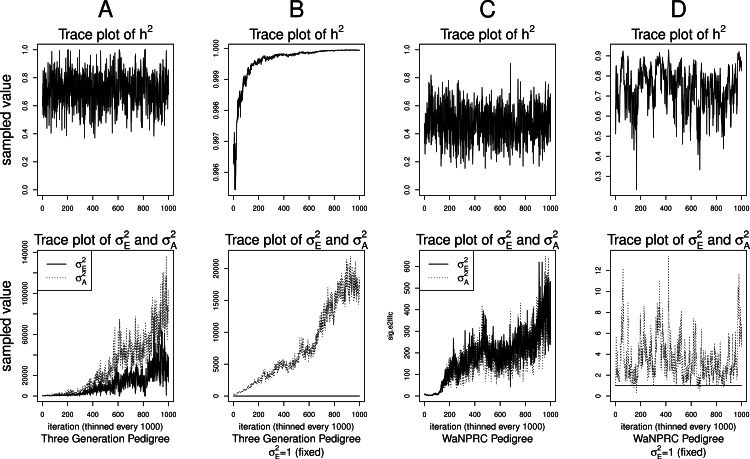
Variance components and heritability traceplots.Four scenarios are shown here, with traceplots of \documentclass[12pt]{minimal}
\usepackage{amsmath}
\usepackage{wasysym} 
\usepackage{amsfonts} 
\usepackage{amssymb} 
\usepackage{amsbsy}
\usepackage{upgreek}
\usepackage{mathrsfs}
\setlength{\oddsidemargin}{-69pt}
\begin{document}
}{}${h}^{2}={\sigma }_{A}^{2}/({\sigma }_{A}^{2}+{\sigma }_{E}^{2})$\end{document}h2=σA2/σA2+σE2 on top, and traceplots of the individual variance components on the bottom. The first scenario (column A) is the three generation pedigree. While the MCMC samples of each individual variance component clearly do not show convergence (bottom), we observe that when we examine the corresponding values of h2, this does appear to be stable (top). Conversely, when we fix \documentclass[12pt]{minimal}
\usepackage{amsmath}
\usepackage{wasysym} 
\usepackage{amsfonts} 
\usepackage{amssymb} 
\usepackage{amsbsy}
\usepackage{upgreek}
\usepackage{mathrsfs}
\setlength{\oddsidemargin}{-69pt}
\begin{document}
}{}${\sigma }_{E}^{2}=1$\end{document}σE2=1, this does not appear to stabilize the MCMC samples of \documentclass[12pt]{minimal}
\usepackage{amsmath}
\usepackage{wasysym} 
\usepackage{amsfonts} 
\usepackage{amssymb} 
\usepackage{amsbsy}
\usepackage{upgreek}
\usepackage{mathrsfs}
\setlength{\oddsidemargin}{-69pt}
\begin{document}
}{}${\sigma }_{A}^{2}$\end{document}σA2 here, and h2 → 1 as shown in the top and bottom panels of column B. With the WaNPRC pedigree (C and D), we again observe that without fixing \documentclass[12pt]{minimal}
\usepackage{amsmath}
\usepackage{wasysym} 
\usepackage{amsfonts} 
\usepackage{amssymb} 
\usepackage{amsbsy}
\usepackage{upgreek}
\usepackage{mathrsfs}
\setlength{\oddsidemargin}{-69pt}
\begin{document}
}{}${\sigma }_{E}^{2}=1$\end{document}σE2=1, the MCMC samples of h2 does indicate convergence despite the fact that those for \documentclass[12pt]{minimal}
\usepackage{amsmath}
\usepackage{wasysym} 
\usepackage{amsfonts} 
\usepackage{amssymb} 
\usepackage{amsbsy}
\usepackage{upgreek}
\usepackage{mathrsfs}
\setlength{\oddsidemargin}{-69pt}
\begin{document}
}{}${\sigma }_{A}^{2}$\end{document}σA2 and \documentclass[12pt]{minimal}
\usepackage{amsmath}
\usepackage{wasysym} 
\usepackage{amsfonts} 
\usepackage{amssymb} 
\usepackage{amsbsy}
\usepackage{upgreek}
\usepackage{mathrsfs}
\setlength{\oddsidemargin}{-69pt}
\begin{document}
}{}${\sigma }_{E}^{2}$\end{document}σE2 individually do not. On the other hand, when fixing \documentclass[12pt]{minimal}
\usepackage{amsmath}
\usepackage{wasysym} 
\usepackage{amsfonts} 
\usepackage{amssymb} 
\usepackage{amsbsy}
\usepackage{upgreek}
\usepackage{mathrsfs}
\setlength{\oddsidemargin}{-69pt}
\begin{document}
}{}${\sigma }_{E}^{2}=1$\end{document}σE2=1, we observe that \documentclass[12pt]{minimal}
\usepackage{amsmath}
\usepackage{wasysym} 
\usepackage{amsfonts} 
\usepackage{amssymb} 
\usepackage{amsbsy}
\usepackage{upgreek}
\usepackage{mathrsfs}
\setlength{\oddsidemargin}{-69pt}
\begin{document}
}{}${\sigma }_{A}^{2}$\end{document}σA2 does not “blow up” like it did in the three generation pedigree case, but mixing appears to be poorer with regard to the traceplot of h2. Indeed, in these 1000 MCMC samples, our effective sample size is 15, compared to 615 when \documentclass[12pt]{minimal}
\usepackage{amsmath}
\usepackage{wasysym} 
\usepackage{amsfonts} 
\usepackage{amssymb} 
\usepackage{amsbsy}
\usepackage{upgreek}
\usepackage{mathrsfs}
\setlength{\oddsidemargin}{-69pt}
\begin{document}
}{}${\sigma }_{E}^{2}$\end{document}σE2 is not fixed to 1.